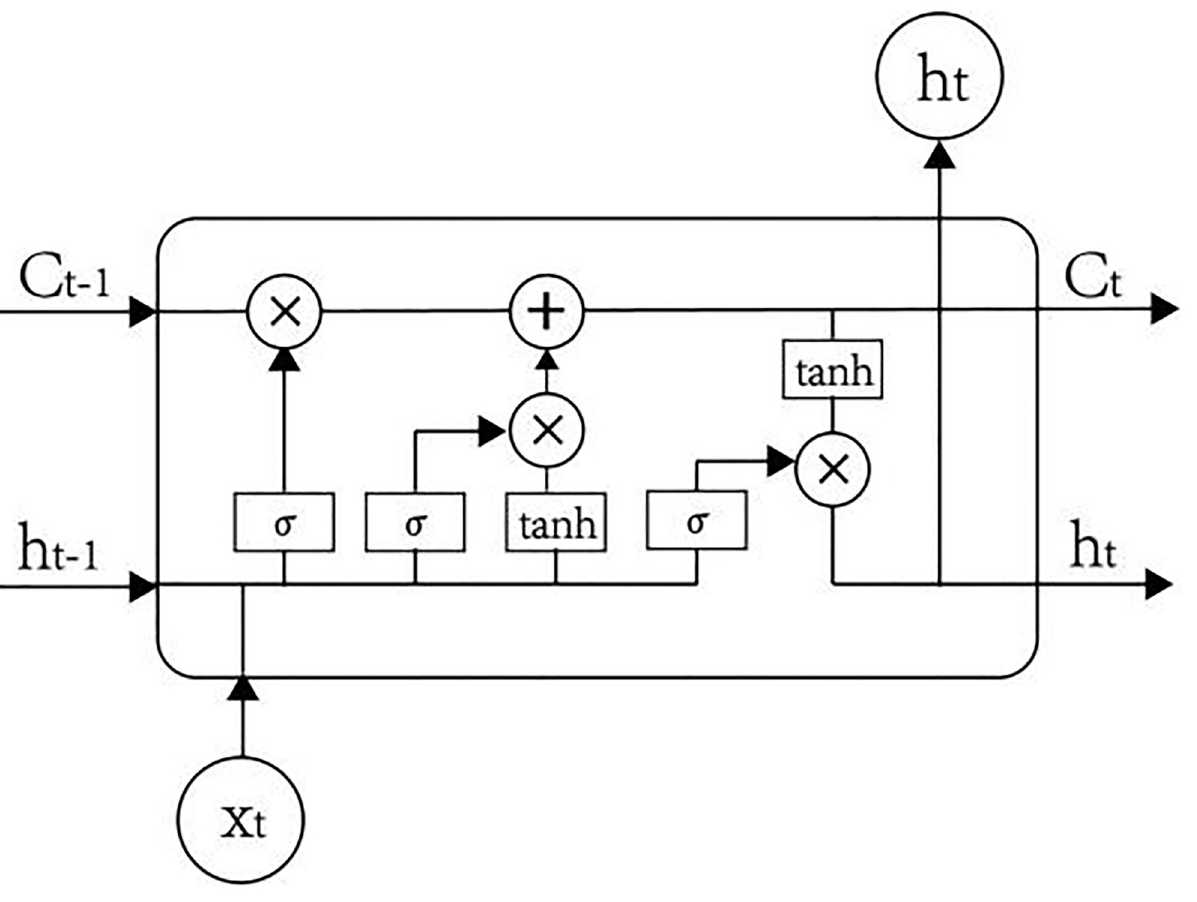
Fig 1. Structrue of LSTM